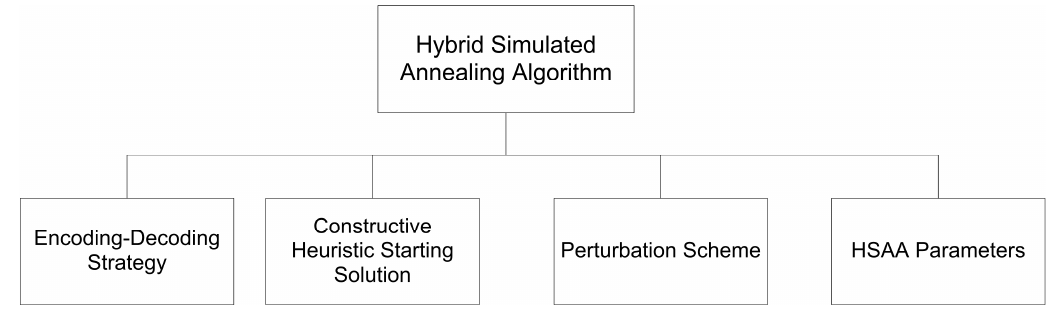
Figure 2. The elements of HSAA.